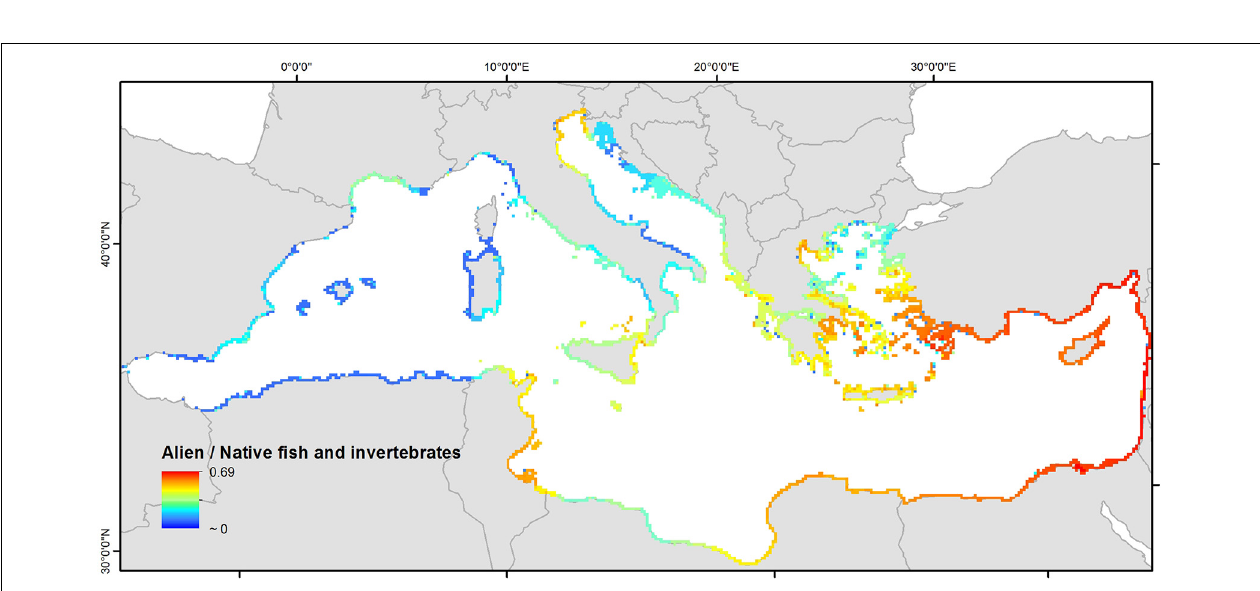
FIGURE 8 | Alien-to-native ratio of fish and invertebrates richness in the coastal areas of the Mediterranean Sea. Note: Distributional data were available for a limited number of native